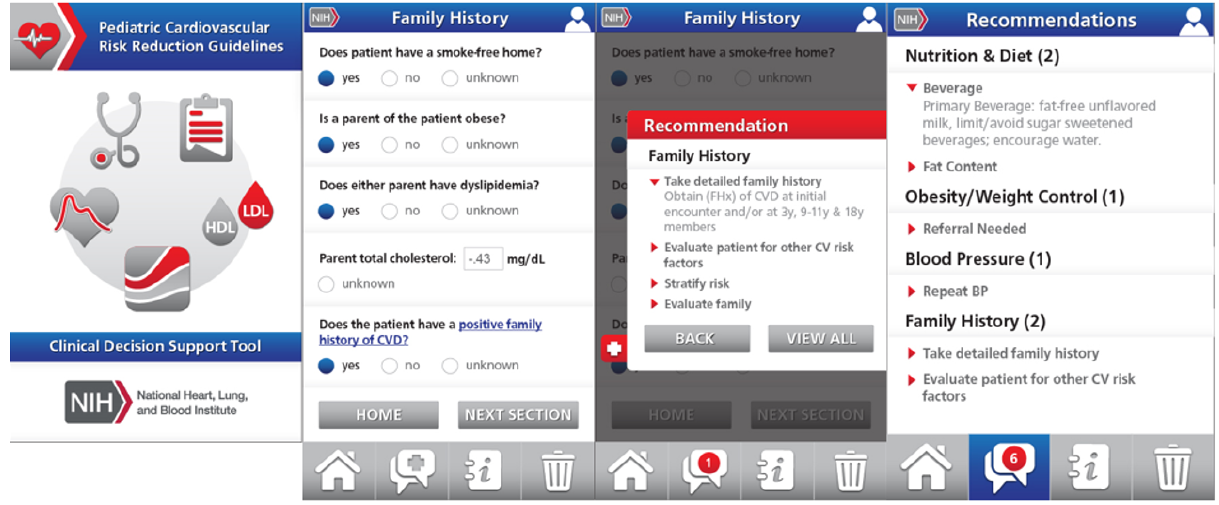
Figure 1. Pediatric cardiovascular (CV) risk-reduction clinical decision support app home screen and modules. BP: blood pressure; CVD: cardiovascular disease; FHx: family history; HDL: high-density lipoprotein; LDL: low-density lipoprotein; NIH: National Institutes of